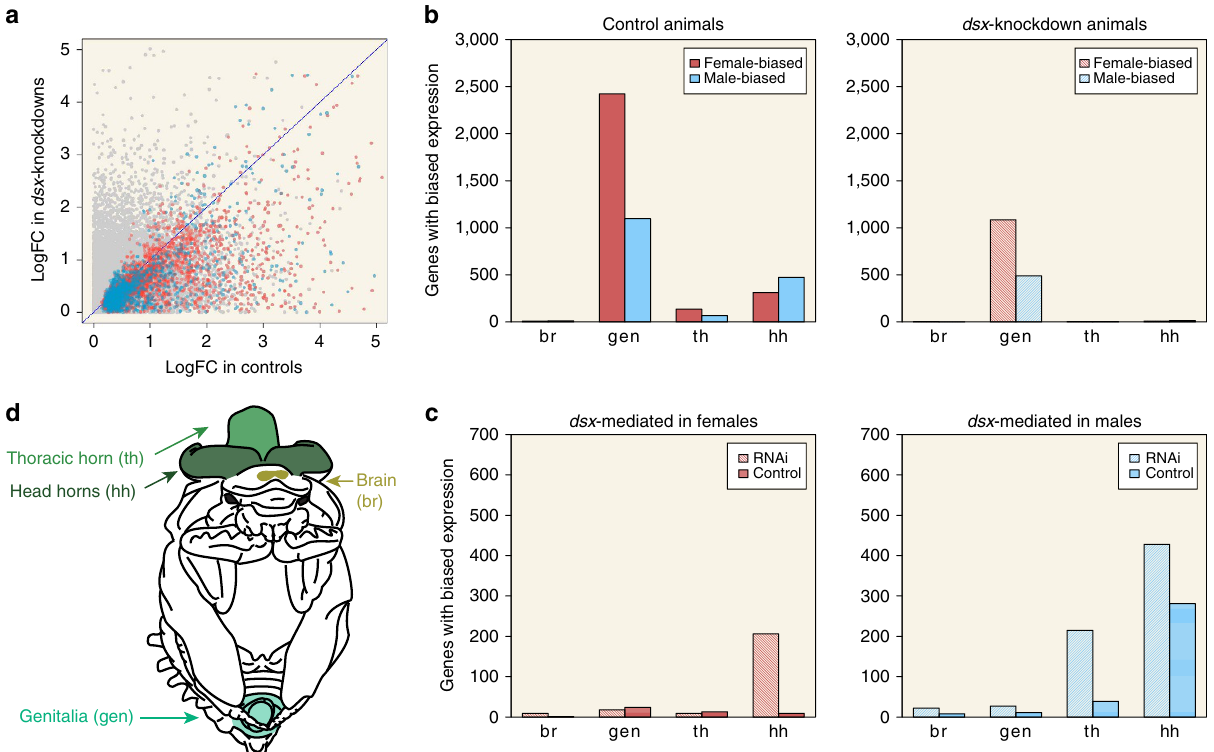
Figure 2 | dsx RNAi reduces sex-biased gene expression across horned beetle tissues. ( a ) Degree of significantly ( P adj o 0.05) female- (pink) or male-biased (blue) gene expression in control animals measured as log-transformed fold change in FPKM ( x axis) plotted against the corresponding level of expression in dsx RNAi animals ( y axis). Genes that did not have significantly sex-biased expression are plotted in grey. Blue line reflects equally sex-biased expression in control and dsx RNAi individuals. ( b ) dsx RNAi reduces the number of O. taurus genes exhibiting significant sex-bias in control individuals. The number of genes with significantly ( P adj o 0.05) female-biased (solid pink) or male-biased (solid blue) expression in control animals (total ¼ 4,285) was reduced B 2.7-fold when assessed in dsx RNAi animals (pink and blue lines; total ¼ 1,596). ( c ) dsx RNAi females (pink lines) overexpress more genes relative to control females (solid pink) in head horns only, indicating that, in females, Dsx directly or indirectly suppresses the expression of downstream genes in that specific tissue. Dsx RNAi males (blue lines) also overexpress as many or more genes relative to control males (solid blue), but do so across tissues, indicating that, in males, Dsx acts to directly or indirectly suppress the expression of downstream targets across a broader range of target tissues. In addition, in head and thoracic horns, control (solid blue) males overexpress many genes relative to dsx RNAi males (blue lines), suggesting that, in males but not females, Dsx also directly or indirectly activates the expression of many downstream targets. ( d ) Tissues analysed in this study were derived from 1st day pupae, and included brains (gold), genitalia (teal), thoracic horn (light green) and head horns (dark expression (Fig. 3b; lower left), whereas dsx RNAi females solely exhibited an elevated degree of male-biased gene expression (Fig. 3b; lower right). Together, these data suggest that Dsx directly or indirectly modulates sex-biased gene expression across all four tissues assessed in this study (brains, genitalia, thoracic horns and head horns) in males, but only in a single tissue in females (head horns) by specifically suppressing genes with male-biased expression (Fig. 3c).